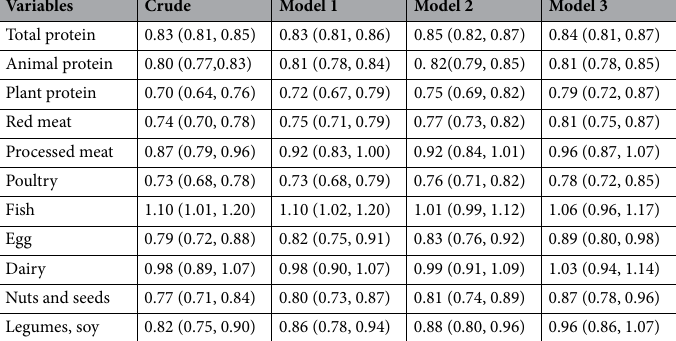
Table 3. The odds ratio for metabolic syndrome per each increment in the frequency of consumption of different protein source. Model 1: Adjusted for age (year) and sex (men/women). Model 2: Additionally adjusted for physical activity, current smoker and BMI. Model 3: Additionally adjusted for fruits and vegetables, cereal and protein